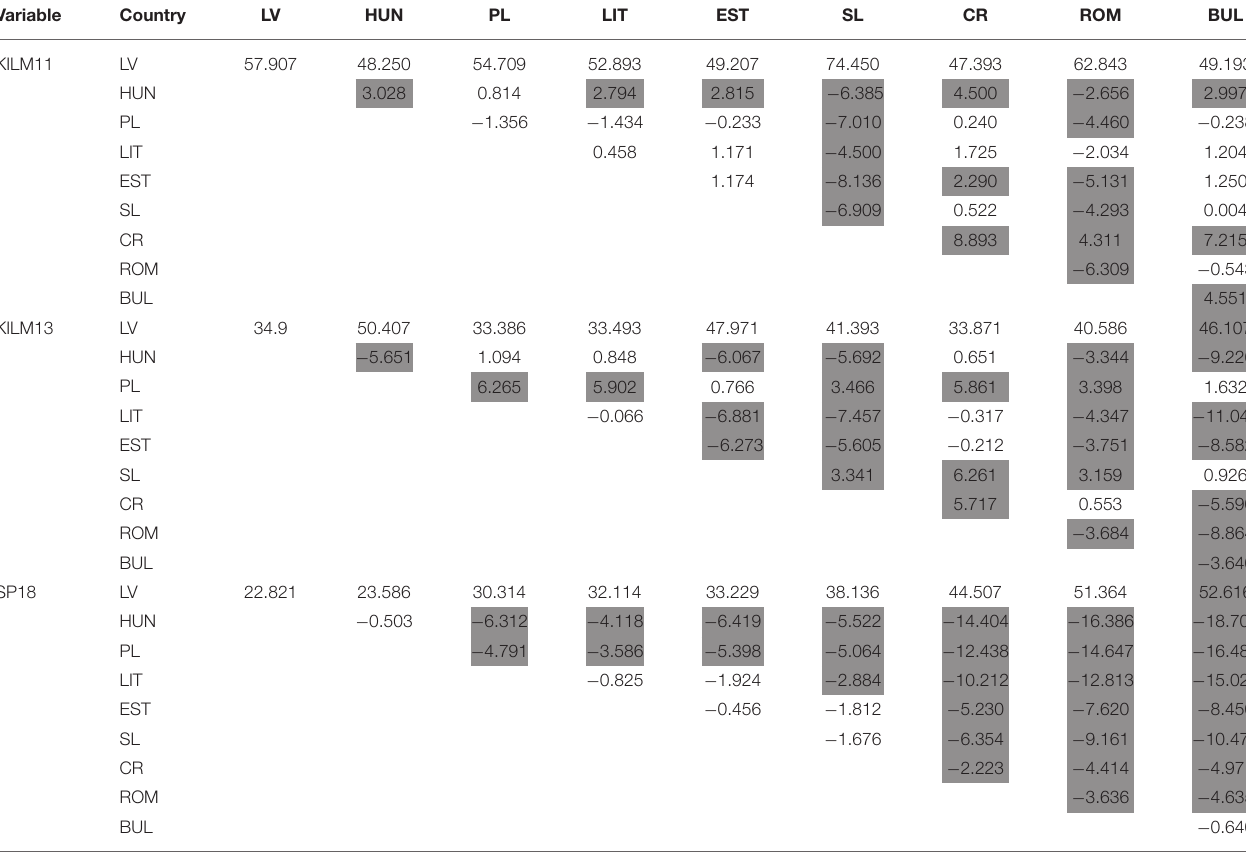
TABLE 10 | Test for significance of mean differences for men (statistically significant differences market as gray areas). Variable